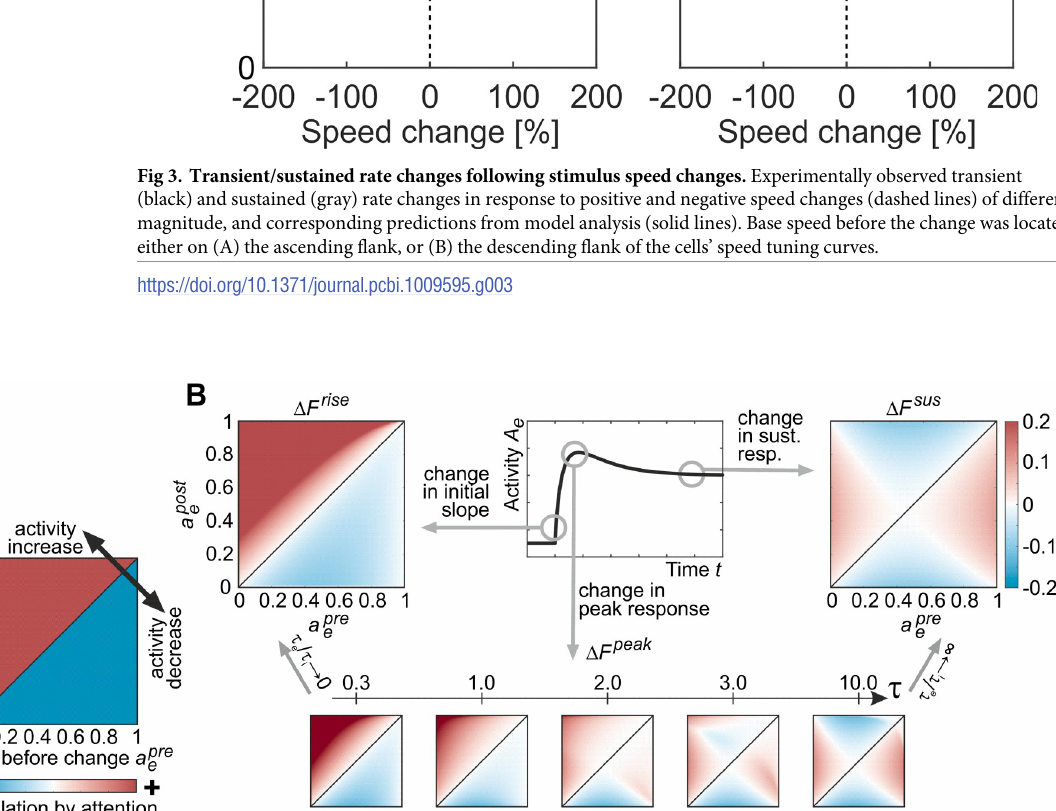
/ τ and becomes similar to Δ F rise for τ / τ ! 0 and similar to e i e i